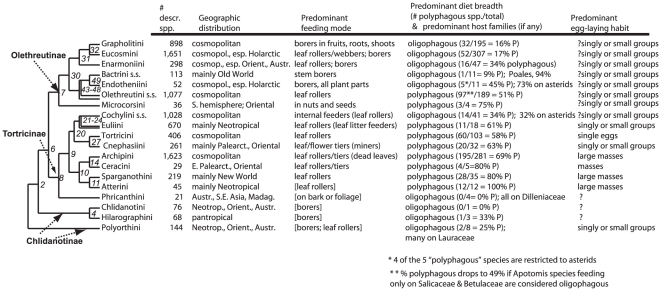
Synopsis of species diversity, distribution and larval host-plant use for the tribes of Tortricidae studied, mapped onto a phylogeny condensed from
Fig. 3.

The multiple branches leading to the names Eucosmini and Olethreutini s.s. denote the paraphyly of these tribes discovered here. Col. 1 = number of described species, taken from Table 3. Col. 2 = summary of geographic distributions, following Horak [29]. Cols. 3, 4, 5 = summary statements of predominant mode of larval feeding, host range, host taxa used and egg-laying habits, following Horak [29], Powell et al. [33] and J. Brown et al. [56]. ‘[]’ denotes assertion based on very few observations; preceding question mark denotes assertion based on uncertain or conflicting information; ‘( )’ denotes habits significantly represented but markedly less common than alternative; ‘;’ separates habits of similar frequency. In column 4, “oligophagous” = feeding on a single plant family, “polyphagous” = feeding on two or more plant families, as described in the text. Numbers in parentheses, compiled from Brown et al. [56], are number of polyphagous species/total number of species with two or more foodplant observations = % polyphagous species.